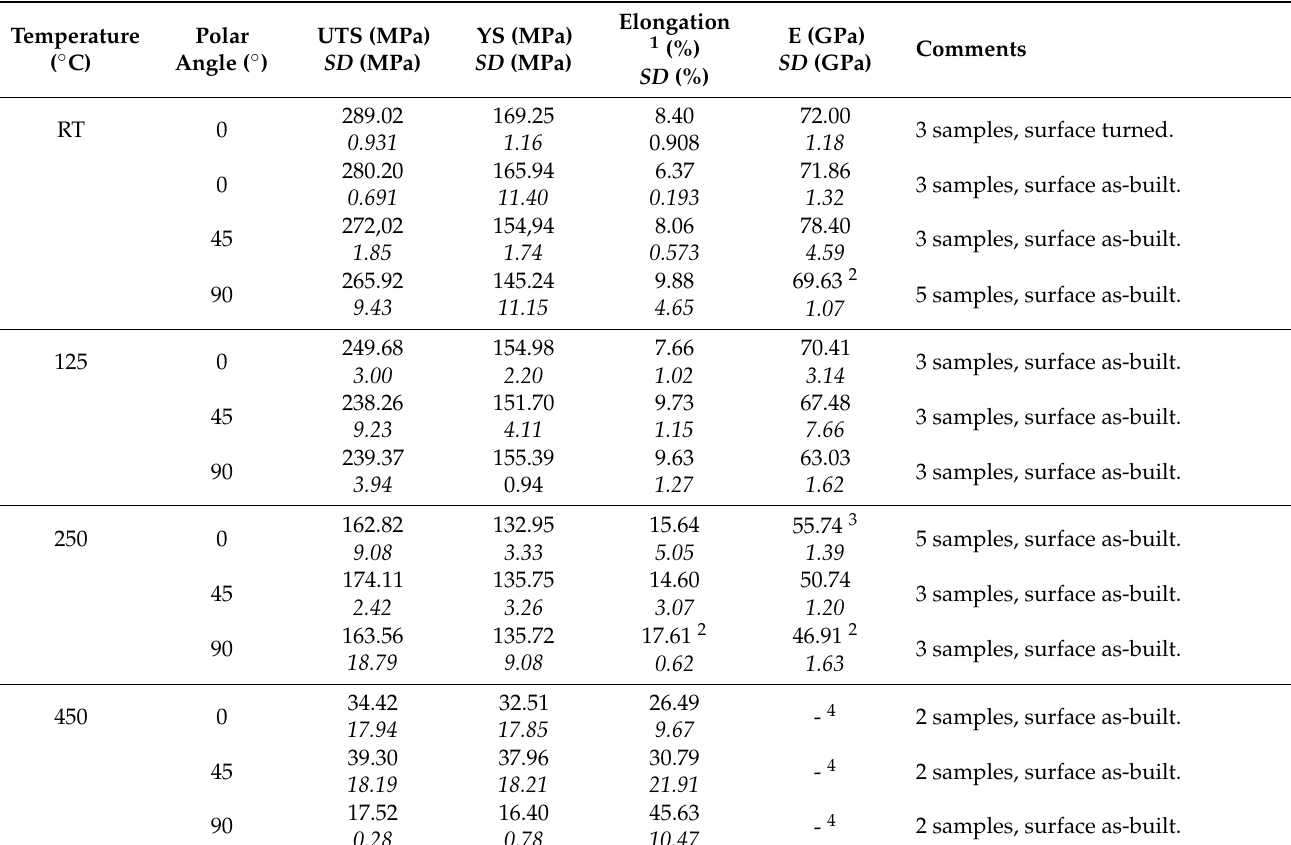
Table A2. Overview of the data measured in the course of the present study, grouped according to the test